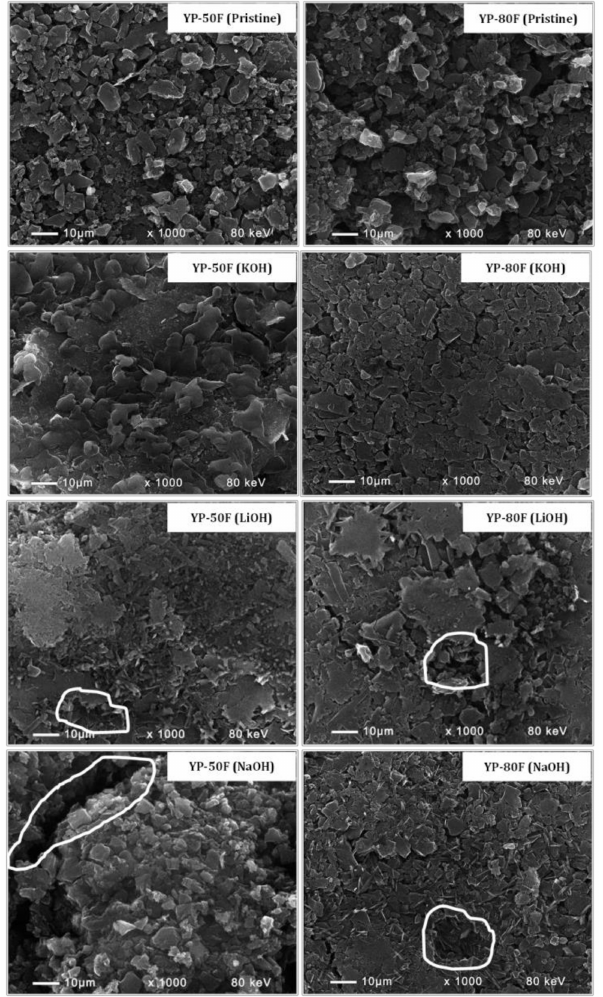
Figure 6. SEM images of pristine electrodes, and after electrochemical tests in KOH, LiOH, NaOH electrolytes. The white lines highlight the development of cracks and faults on the